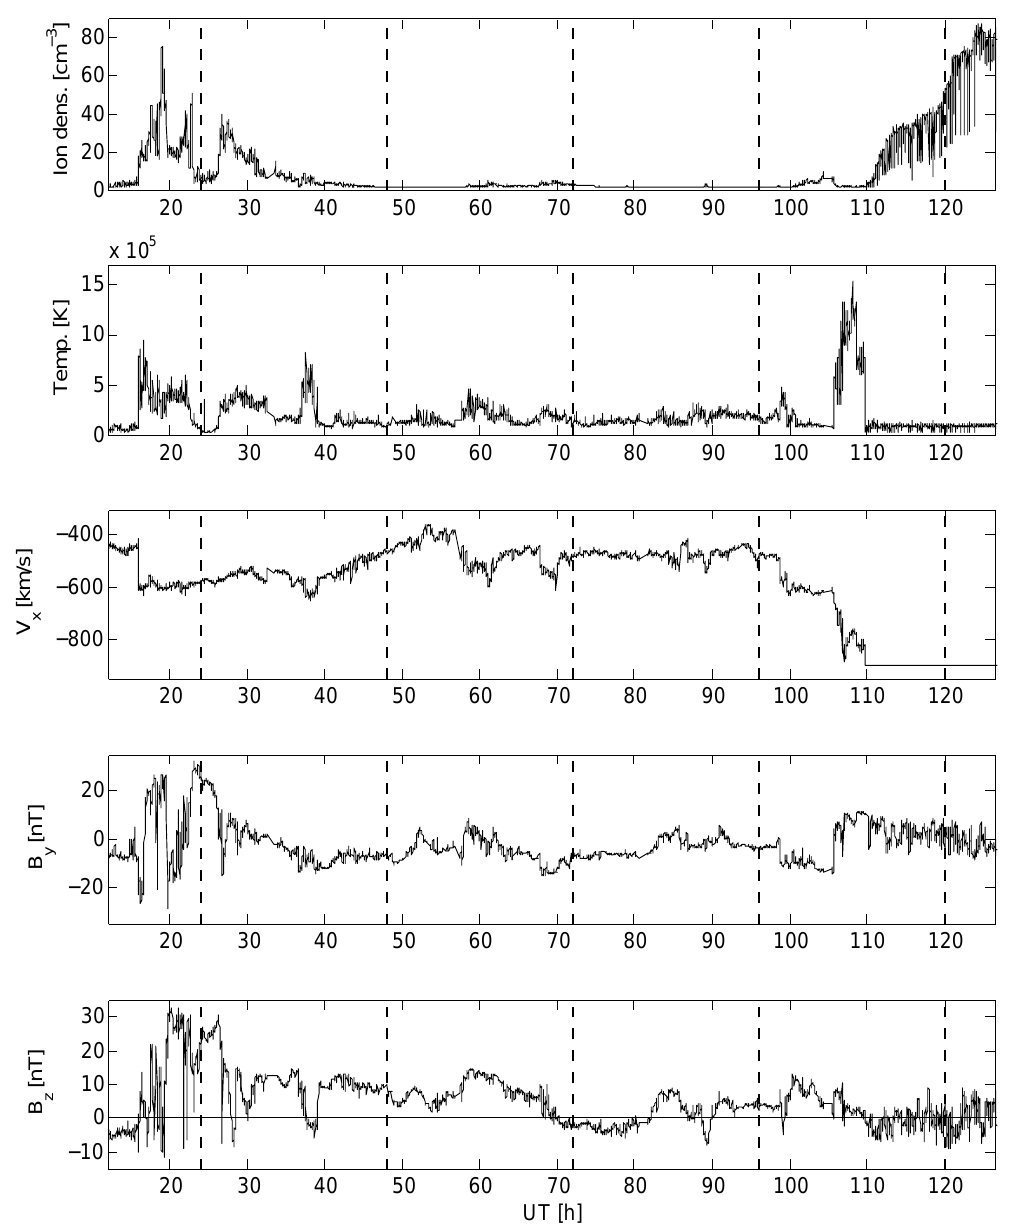
Fig. 1. The solar wind driver of the BATS-R-US run. The time is UT hours from the beginning of 24 October 2003. The vertical dashed lines indicate the beginning of each new UT day and the solid straight line in the bottom panel indicates the zero-level. stereographic projection and the currents were interpolated to D) ground conductivity structure. In using CIM we assume a uniform rectangular Cartesian grid. 5.) Additional currents that field-aligned currents are exactly vertical and we de- carrying out the current essentially from and to infinity were added to the edges of the Cartesian grid. This step is neces- sary to avoid the strong artificial field-aligned currents at the edges of the grid. The additional currents eliminate the field- aligned currents at the edges completely. 6.) The Complex Image Method (CIM) (Boteler and Pirjola, 1998; Pirjola and Viljanen, 1998) was used to compute the ground response Fast Fourier to the ionospheric driving with given one-dimensional (1-